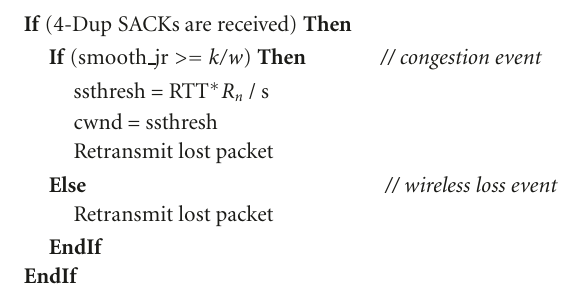
Algorithm 1: Pseudocode of JSCTP when four DupSACKs